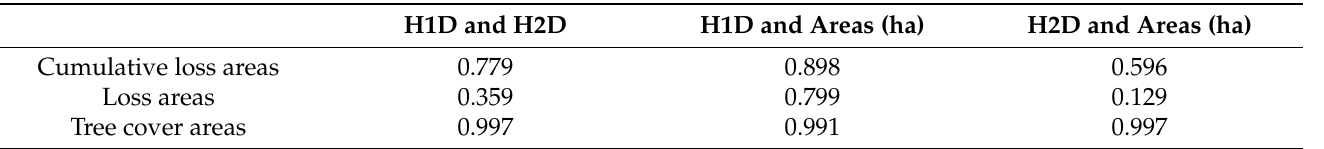
Figure 4. Higuchi dimensions 1D and 2D of loss, cumulative loss, and tree cover areas from Parâng Mountains. Table 2. Coefficients of determination R 2 for linear regressions between Higuchi dimensions 1D and 2D and between Higuchi dimensions and corresponding areas.